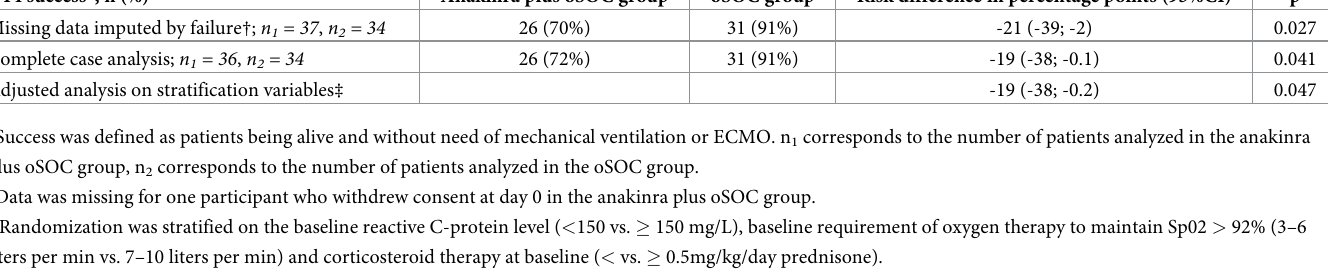
disease severity classification significantly differed between the two groups (p = 0.008) and we observed a higher proportion of patients hospitalized not requiring supplemental oxygen (WHO score 3) or death (WHO score 7) in the anakinra group than in the oSOC group, respectively 43% vs. 24% and 17% vs. 0%. The evolution of the NEW score over the 28-day fol- low-up is given in S2 Fig, no difference was found between the two groups; time by treatment interaction 0.02 (95% CI, -0.08 to 0.13, p = 0.67. After a 28-day follow-up, 9 patients in the anakinra group and 3 in the oSOC group had died. One patient in the oSOC group died after Day 28. Overall survival at day 28 was 75% (95% CI, 62% to 91%) in the anakinra group versus 91% (95% CI, 82% to 100%) (log rank test p = 0.06) (Fig 2A). Causes of death are shown in Table 5. Twenty-one patients were subse- quently admitted in ICU: 9 in the anakinra group vs. 13 in the oSOC group (p = 0.16) (Fig 2B). Seven deaths occurred before admission in ICU (6 in the anakinra group vs. 1 in the oSOC group) During the 28-day follow-up, twenty-nine patients needed ventilation support includ- ing ECMO, MV, non-invasive ventilation and high flow oxygen: 16 in the anakinra group vs. 13 in oSOC (p = 0.65) (Fig 2C). The cumulative incidence of patients who withdrew the need for oxygen support at day 28 was 74% (95% CI, 53% to 87%) in the anakinra and 79% (95% CI, 59% to 90%) in the oSOC group, respectively (p = 0.43) (Fig 2D). The cumulative incidence of discharge at day 28 was 69% (95% CI, 51% to 82%) and 68% (95% CI, 49% to 81%] in the anakinra group respectively (p = 0.64) (Fig 2E).